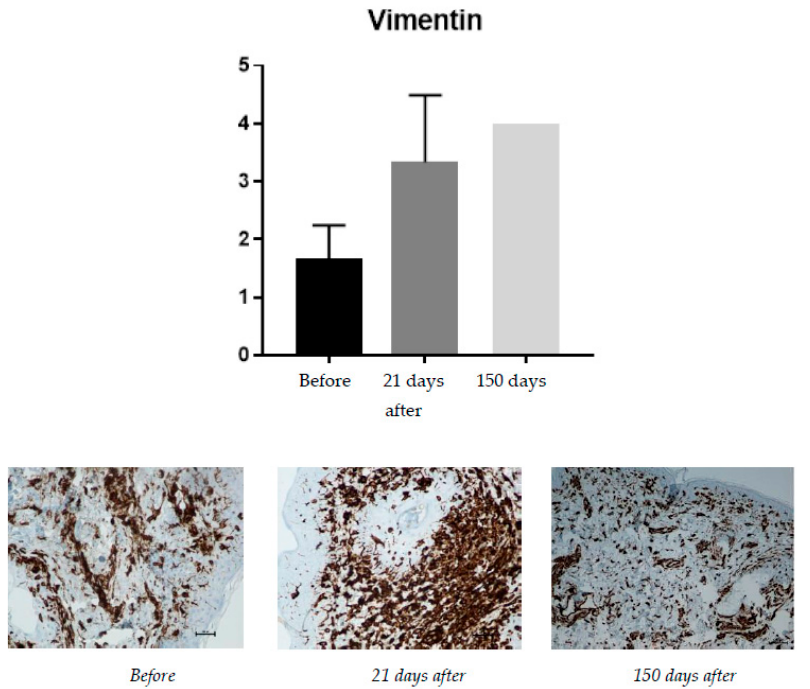
Figure 6. Increase in fibroblasts, from left to right: before treatment; 21 days after treatment; 150 days after treatment.